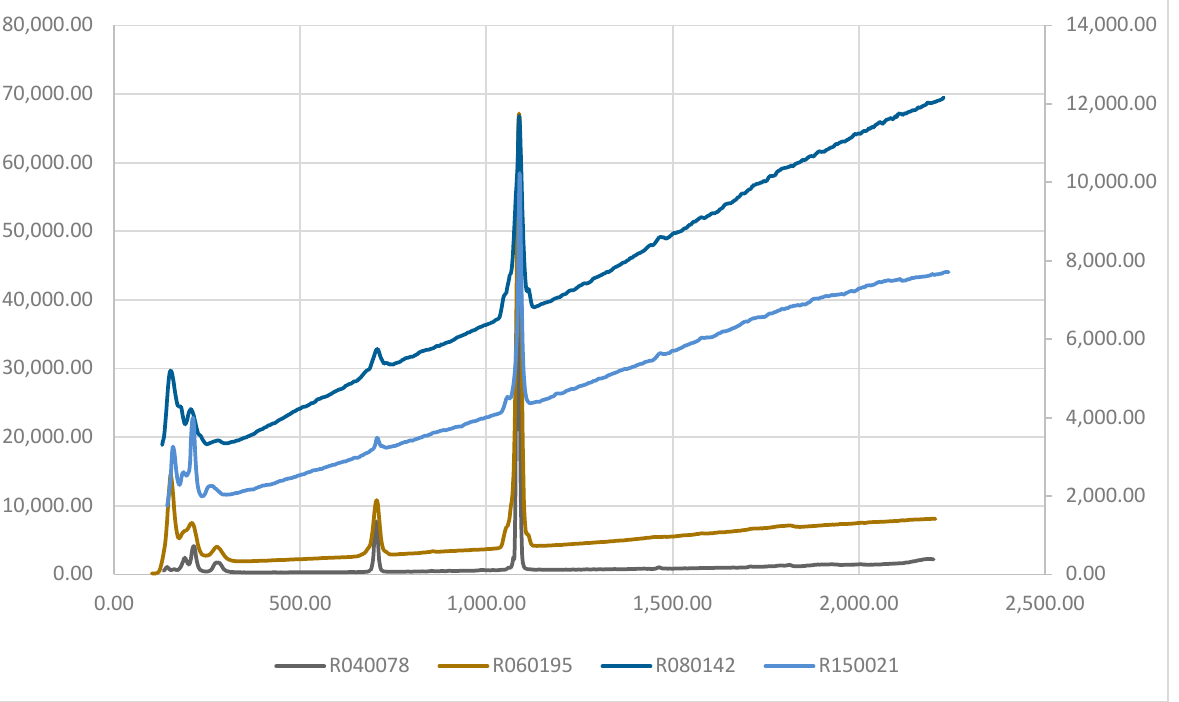
Figure 3. RRUFF aragonite database spectra, where R040078 and R060195 are pure aragonite (gray and gold), R150021 aragonite contains 98.7% of calcium and 0.96% strontium (light blue), and R080142 aragonite contains 96% calcium and 2% strontium (dark blue).